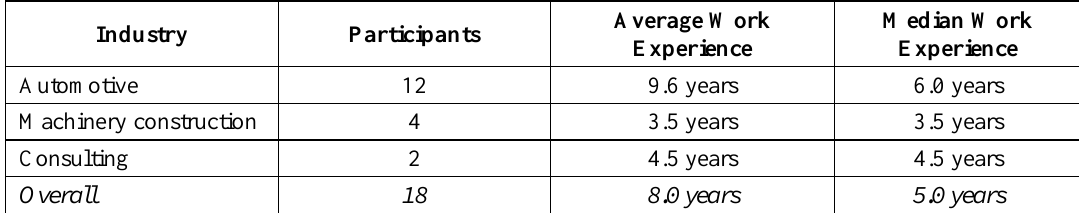
Table 3. Evaluation (step 4): industry distribution of participants (study 2) Industry Participants